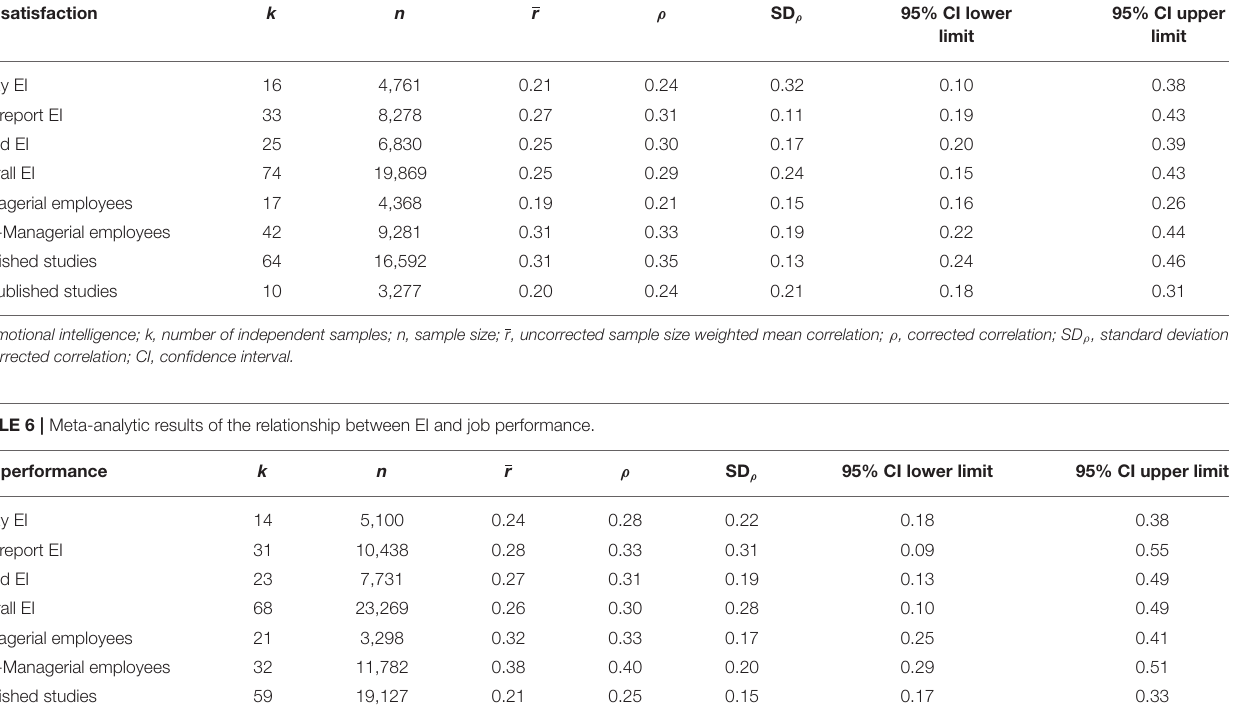
TABLE 5 | Meta-analytic results of the relationship between EI and job satisfaction. Job satisfaction